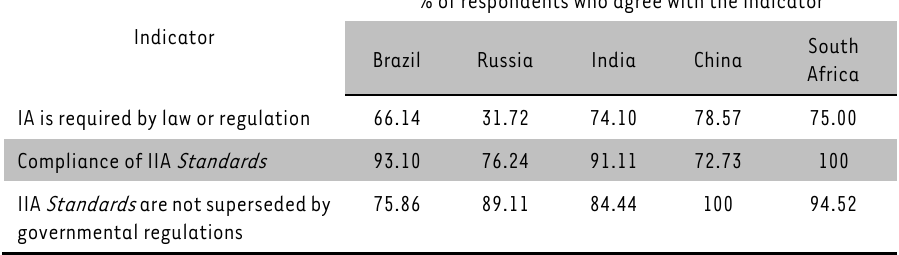
% of respondents who agree with the